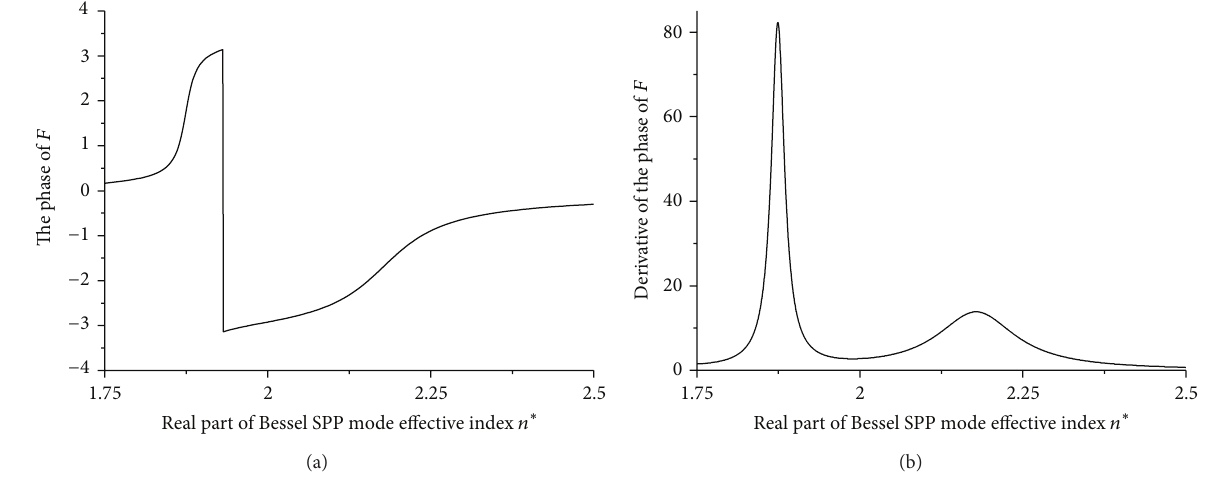
Figure 2: The phase of 𝐹 function (a) and the derivative of the phase of 𝐹 function (b) versus the real part of the Bessel surface plasmon polariton mode effective